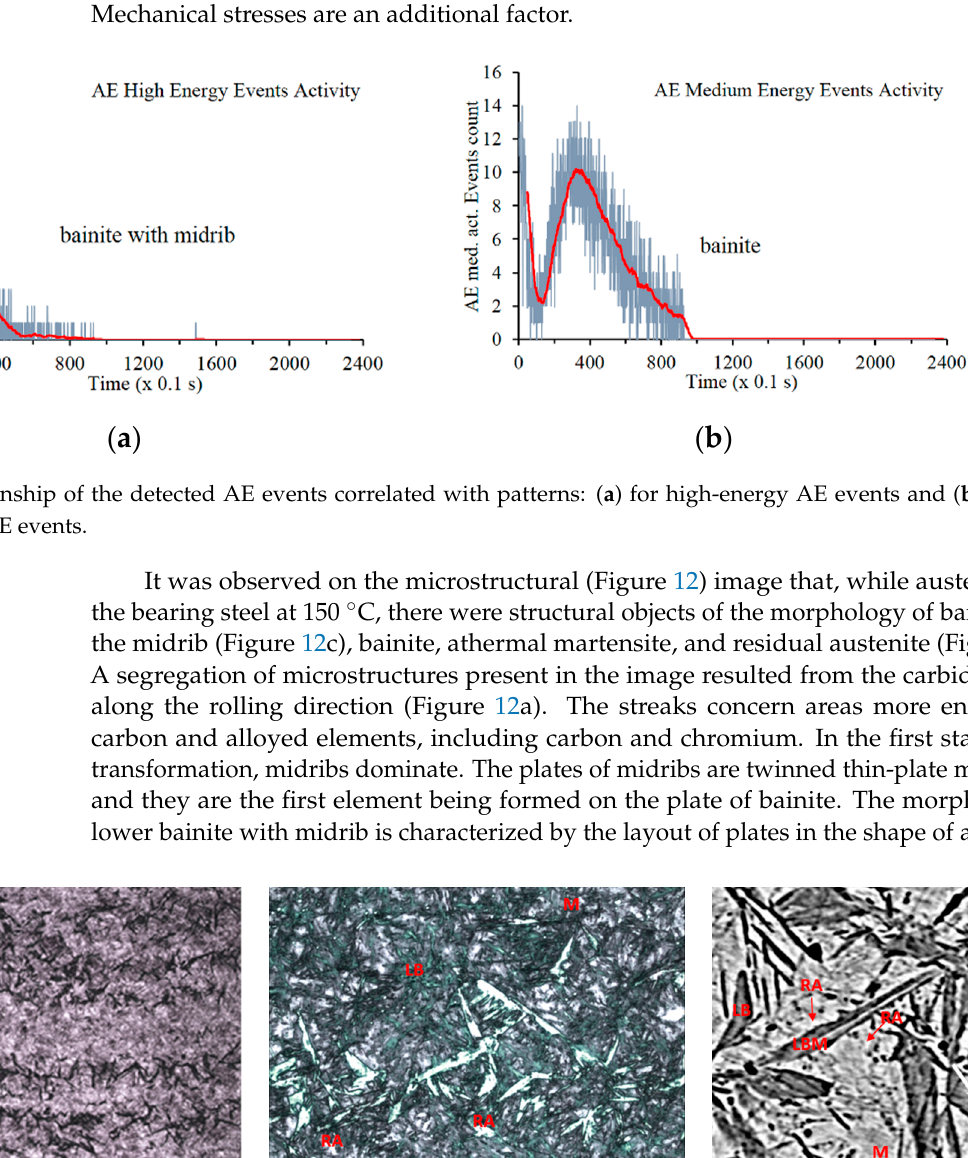
Figure 10. Spectral characteristics for bearing steel indicating energies of event patterns used in artificial neural networks (ANNs): 1—high energy AE events, 2—medium energy AE events, and 3—low energy AE events of background.